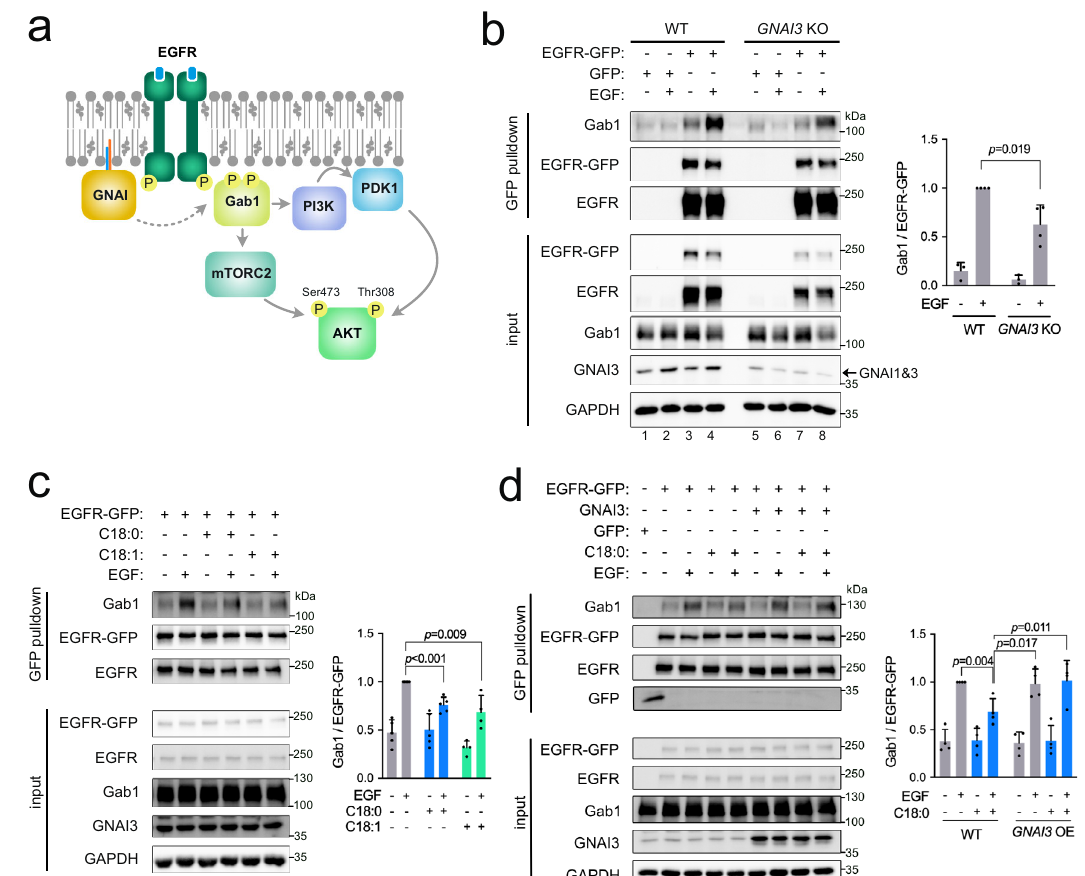
Fig. 5 C18:0 and C18:1 reduce recruitment of Gab1 to EGFR via GNAI proteins. a Schematic diagram of the role of GNAI in EGFR signaling. b The interaction of EGFR-GFP with Gab1 induced by EGF treatment (50 ng/mL for 5 min) is reduced in GNAI3 KO MCF7 cells. Quanti fi ed is the amount of Gab1 in the pulldown normalized to the amount of EGFR-GFP in the pulldown. Data are presented as mean ± SEM of four biological replicates, p -values determined by two-sided t -test with correction for multiple comparisons using the Holm – Sidak method. c Exposure of MCF7 cells to C18:0 or C18:1 (both 100 µ M, 3 h) blunts the interaction of EGFR-GFP with Gab1 induced by EGF (50 ng/mL, 5 min). Quanti fi ed is the amount of Gab1 in the pulldown normalized to the amount of EGFR-GFP in the pulldown. Data are presented as mean ± SEM of four biological replicates, p -values determined by two-sided t -test with correction for multiple comparisons using the Holm – Sidak method. d Overexpression of GNAI3 rescues the effect of C18:0 (100 µ M, 3 h) on Gab1 recruitment to EGFR-GFP upon EGF stimulation (50 ng/mL for 5 min). Quanti fi ed is the amount of Gab1 in the pulldown normalized to the amount of EGFR-GFP in the pulldown. Data are presented as mean ± SEM of four biological replicates and the p -values were calculated by two-sided t -test with correction for multiple comparisons using the Holm – Sidak